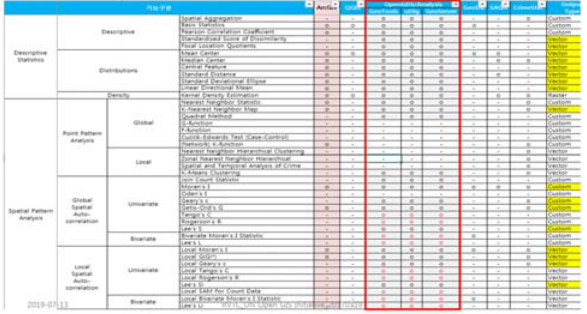
Figure 2. Comparison parts of geospatial analysis functions among GIS SWs